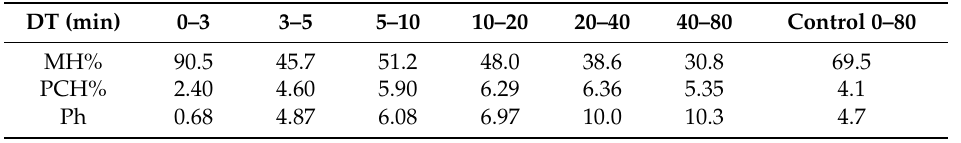
Table 8. Chemical families of Juniperus sabina essential oil (EO) constituents as a function of their elution during hydrodistillation timeframes.